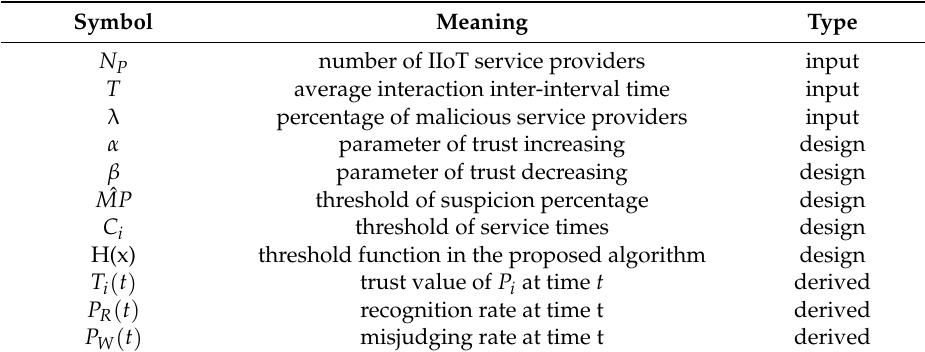
Table 1. The parameters used in the